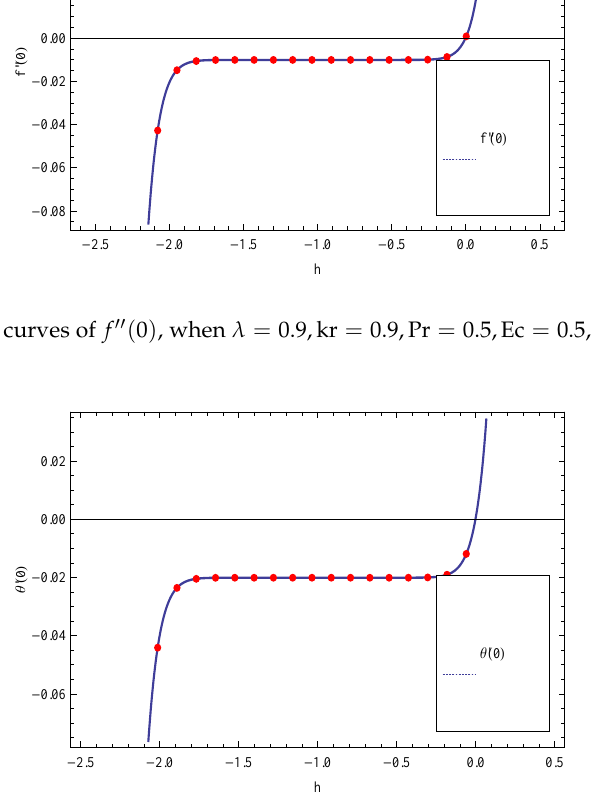
Figure 27. Shows h curves of θ (cid:48) ( 0 ) , for λ = 0.2, S = 0.2,kr = 0.2,Pr = 1,Ec = 0.6,Nb = 1,Nt = 0.1, β = 1 and Sc =